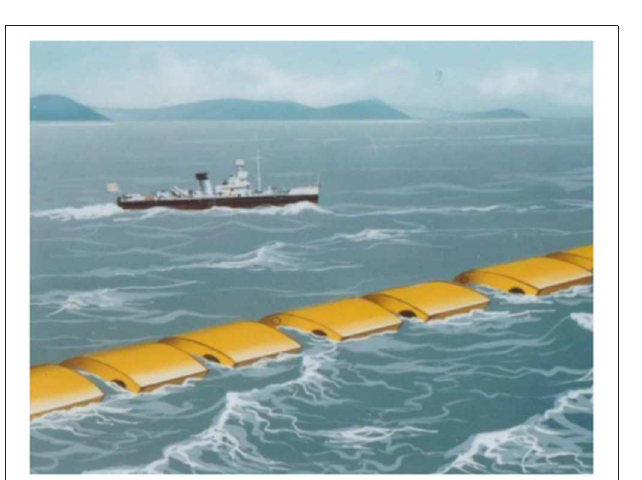
FIGURE 2 | An Edinburgh Duck wave-farm.